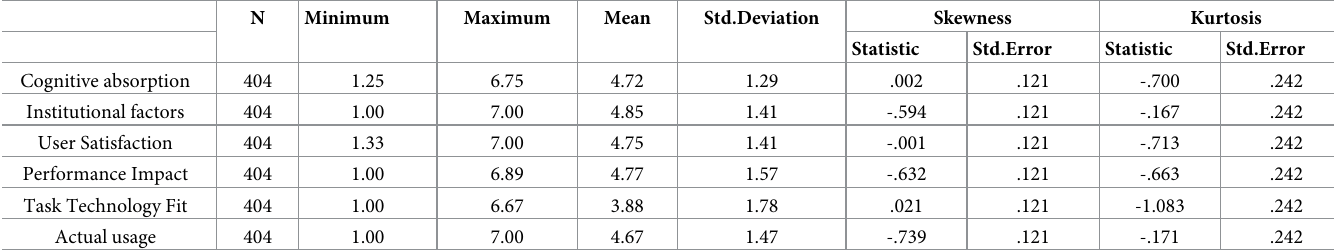
Table 3. Descriptive